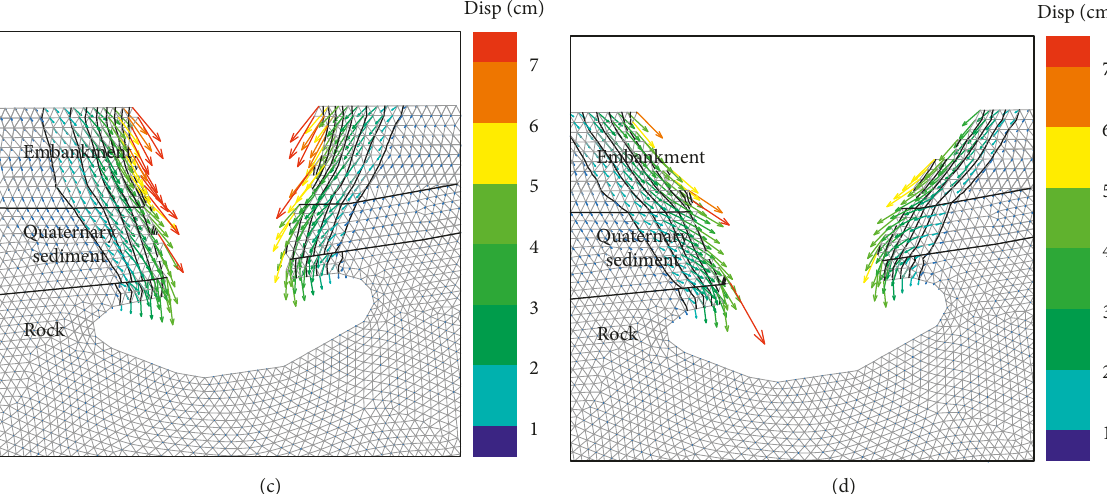
Figure 23: Potential evolution from bedrock sagging sinkhole to bedrock collapse sinkhole. (a) Stage 1. (b) Stage 2. (c) Stage 3. (d) Stage